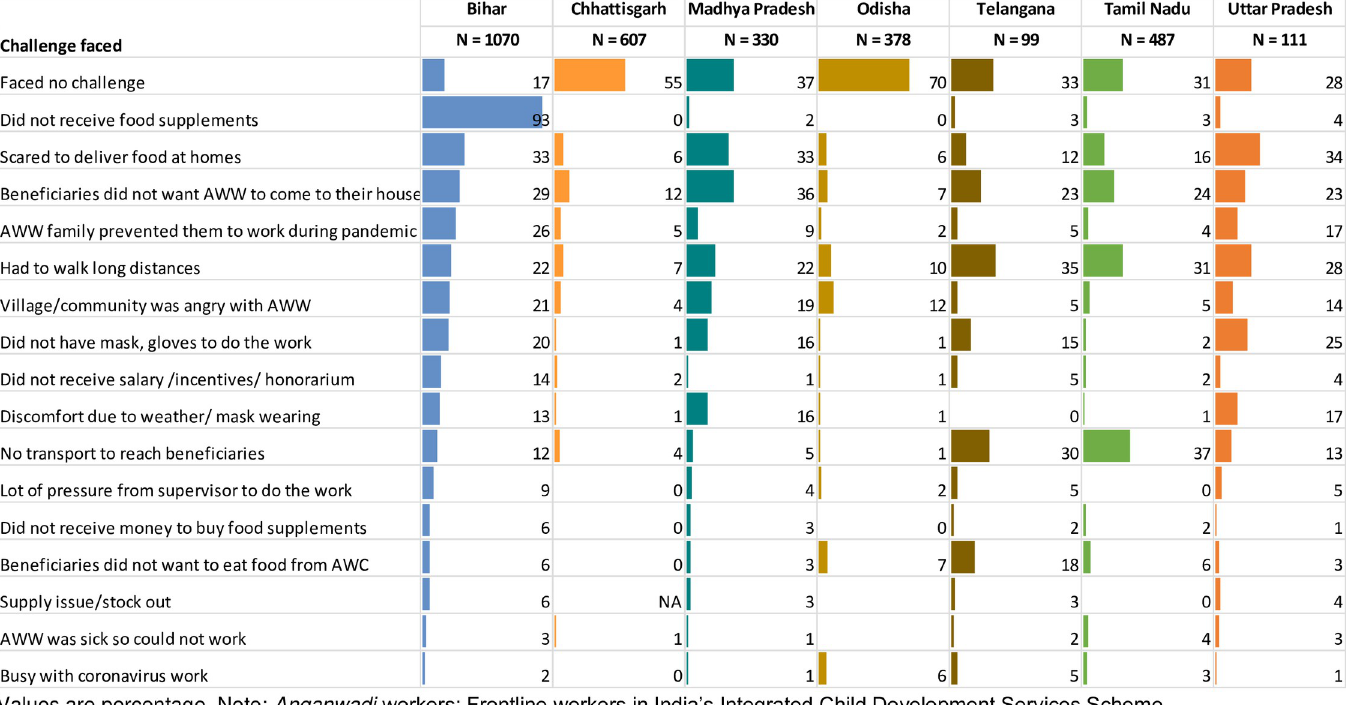
Fig 5. Challenges faced by Anganwadi workers (AWWs) in delivering services during COVID-19 (April 2020). Note: Anganwadi Workers: Frontline workers in India’s Integrated Child Development Services Scheme.